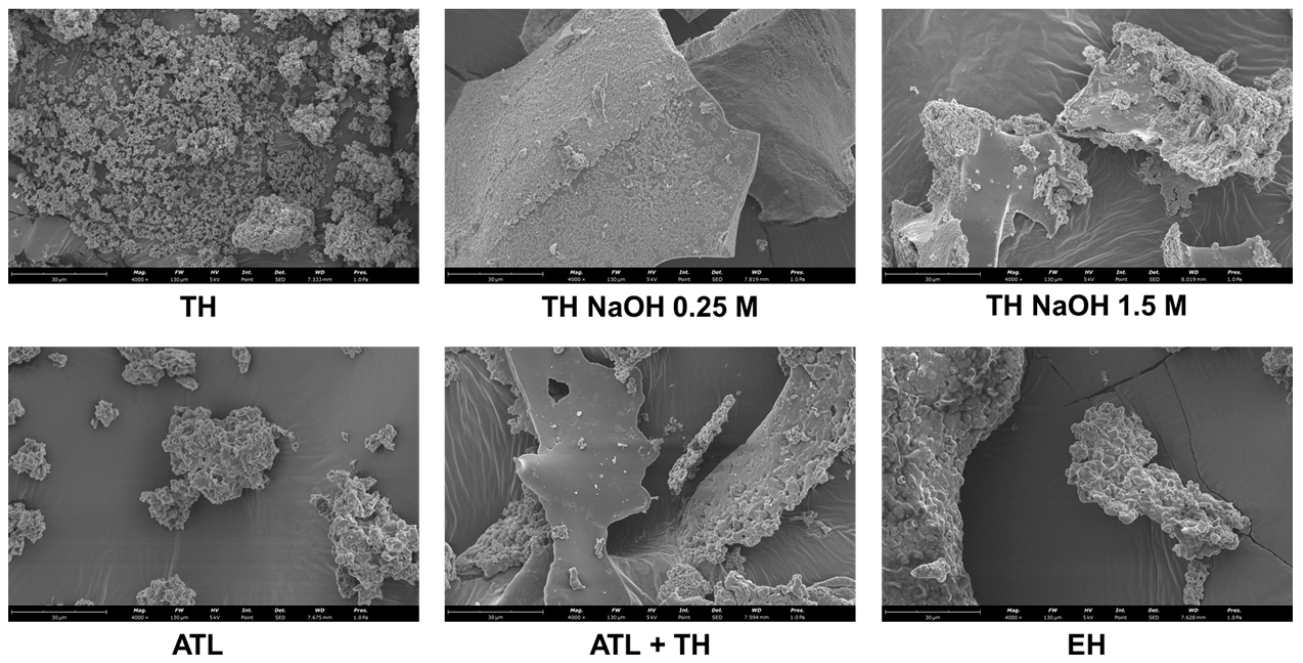
Figure 3. Scanning Electron Microscopy Analyses of the mannans extracts correspondent to the following extraction methods: Thermal Hydrolysis (TH); alkaline Thermal Hydrolysis (TH NaOH 0.25 M and TH NaOH 1.5 M); Autolysis (ATL); Autolysis followed by pH-neutral Thermal Hydrolysis (ATL + TH); and Enzymatic Hydrolysis (EH).